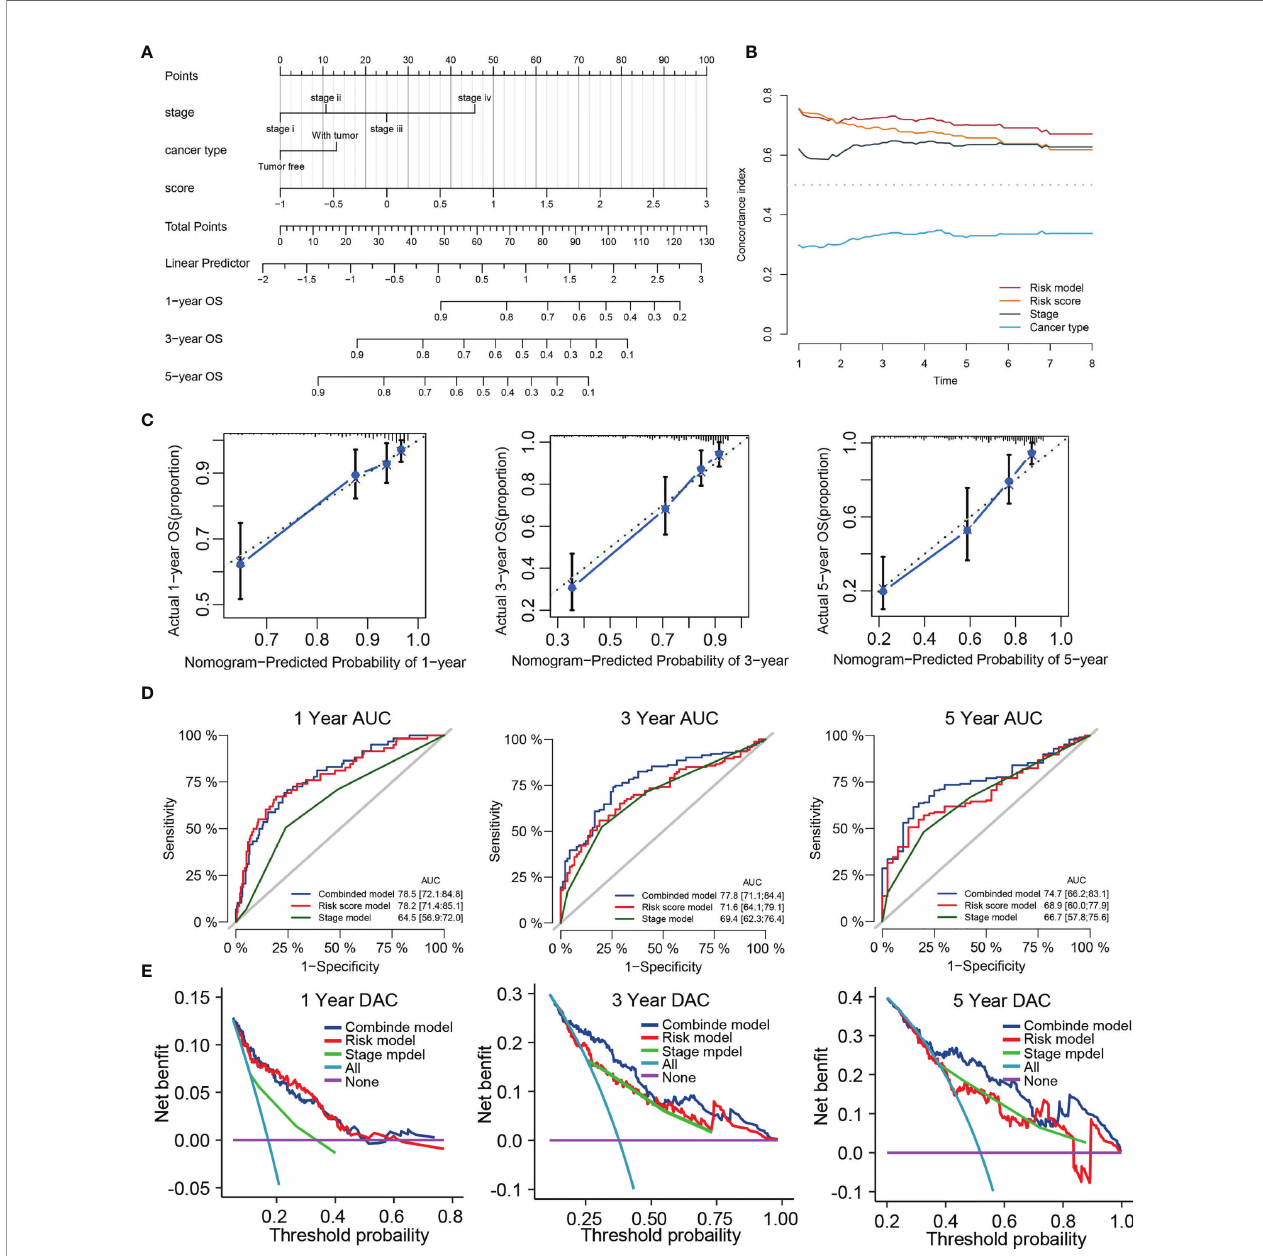
FIGURE 11 | Construction of a nomogram predicting OS based on the independent prognostic factors. (A) Nomogram integrated the TRP score, Stage and cancer type. (B) Time-dependent C-index curves of nomogram, TRP score cancer type and stage. (C) Calibration curve for predicting OS at 1, 3, and 5 years. (D) Time- dependent ROC curves of nomogram, TRP score, and stage at 1, 3, and 5 years. (E) Decision curve analysis of nomogram, TRP score and stage at 1, 3, and 5